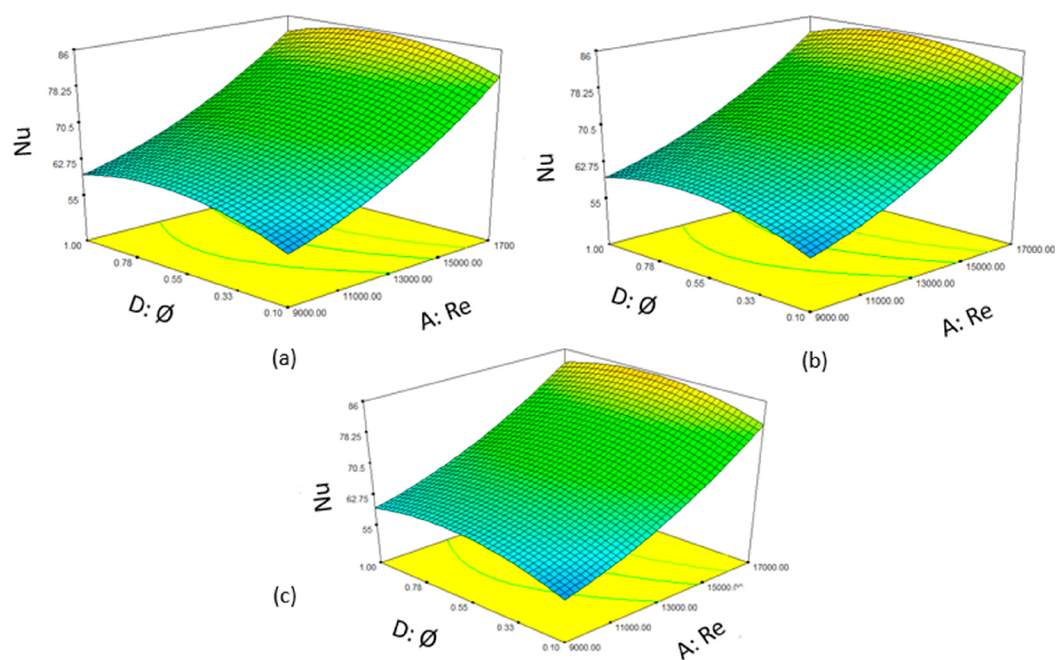
Figure 10. Nusselt number contours and 3D surface formed by the effect of Reynolds number and phase angle at the optimum conditions for the optimization target of maximum Nusselt number and Nano concentration equal to ( a ) 0.1%; ( b ) 0.5%; ( c )